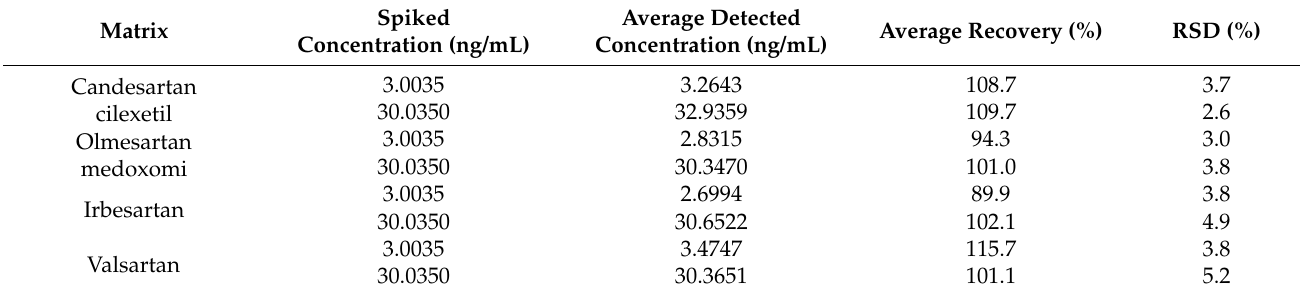
Table 4. Accuracy results of NMBA in sartan substances (mean ± SD, n = 6).